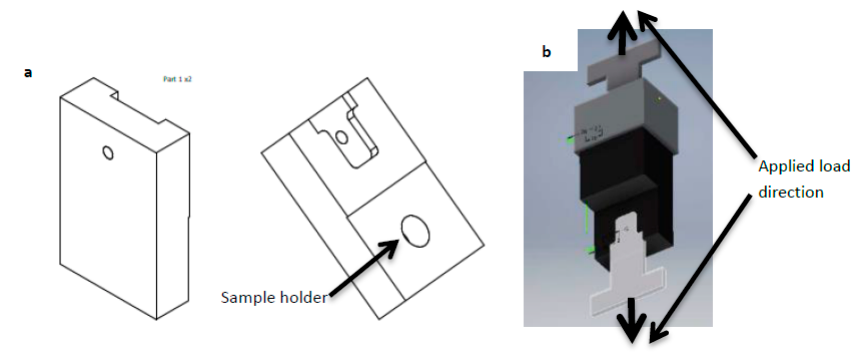
Figure 2. Fixture of the shear testing for bonded samples. ( a ) Back side and front side. ( b ) Full view of the fixture.